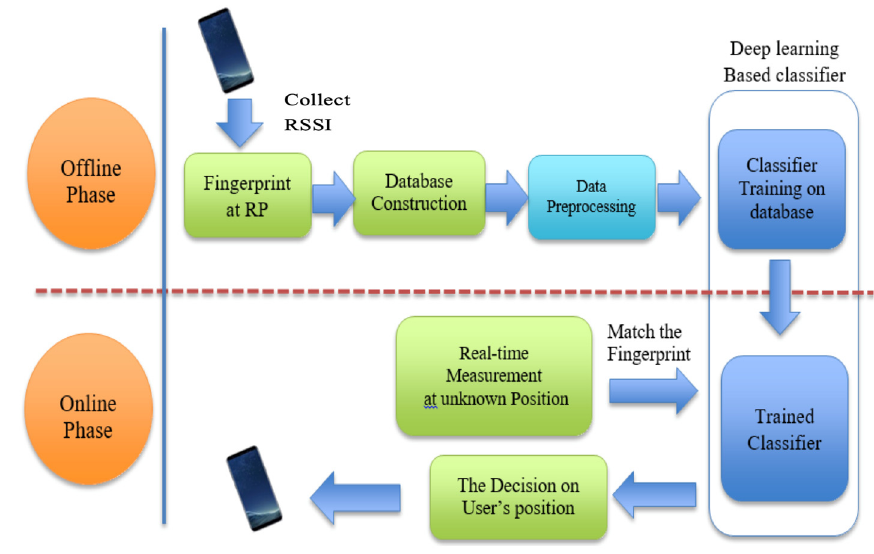
Figure 1. The fingerprint positioning with deep learning classifier.